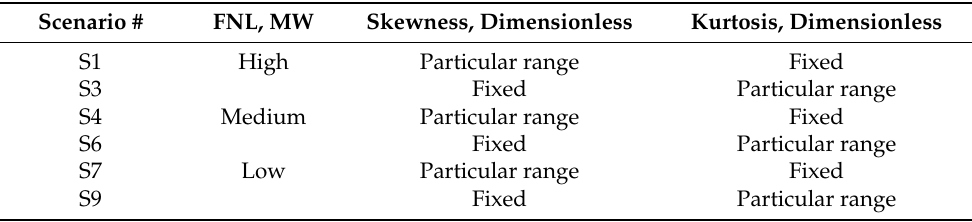
Table 3. Scenarios for three parameters: FNL, skewness ( P sk ), kurtosis ( P k ).